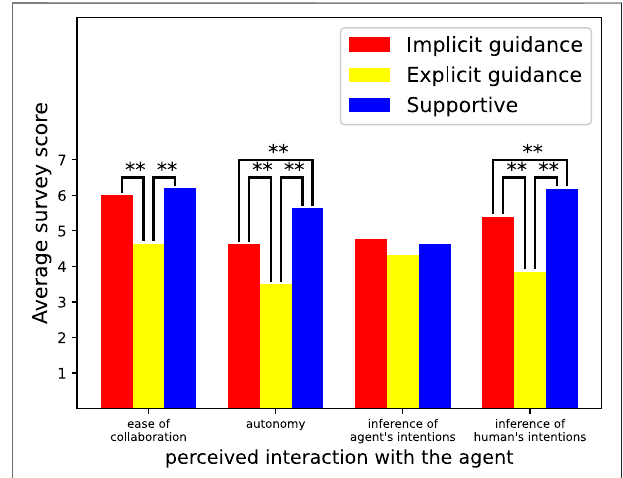
FIGURE 5 | Average survey score about perceived interaction with the